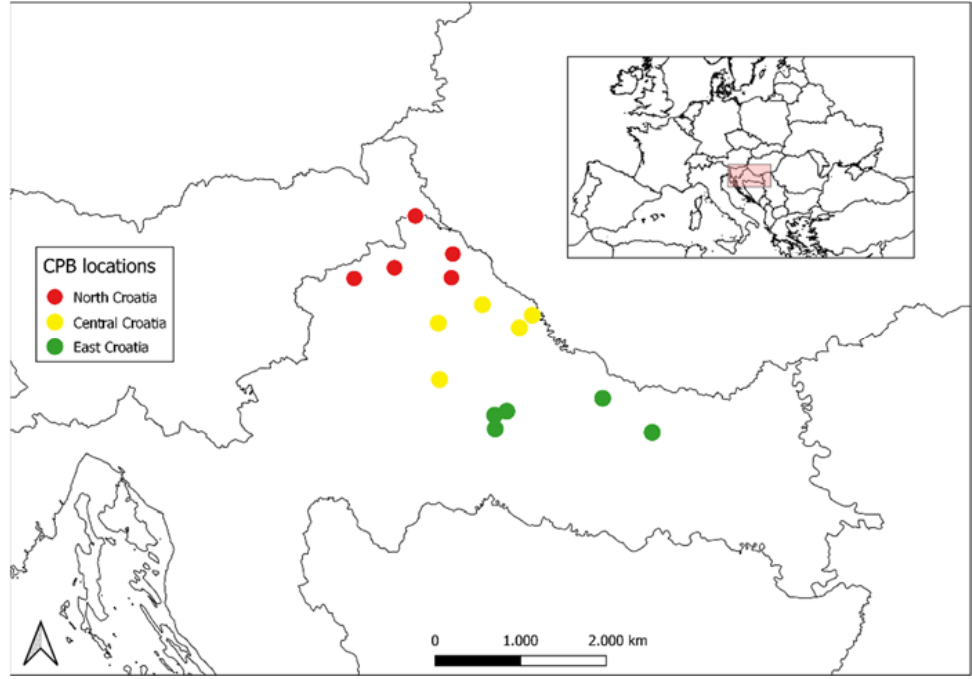
Figure 1. Sampling sites of the Colorado potato beetle in continental